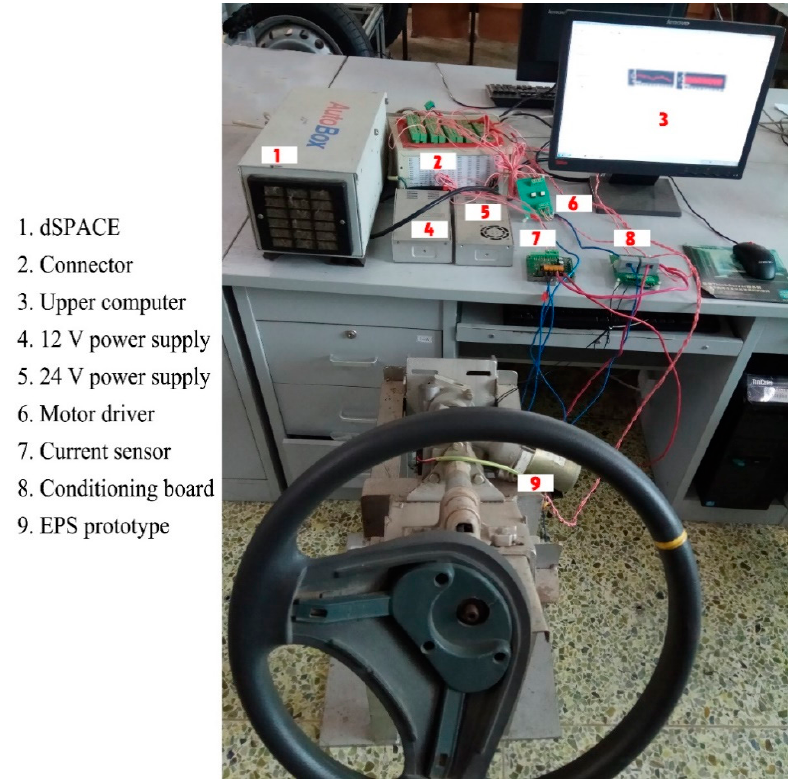
Figure 28. EPS test bench.